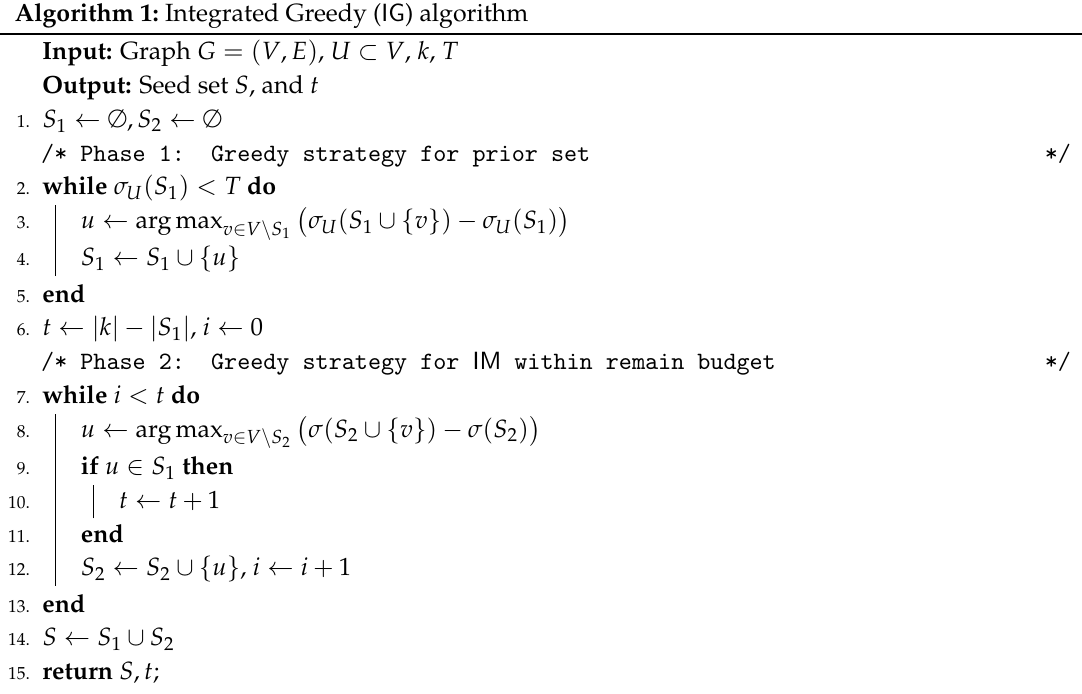
Algorithm 1: Integrated Greedy ( IG )